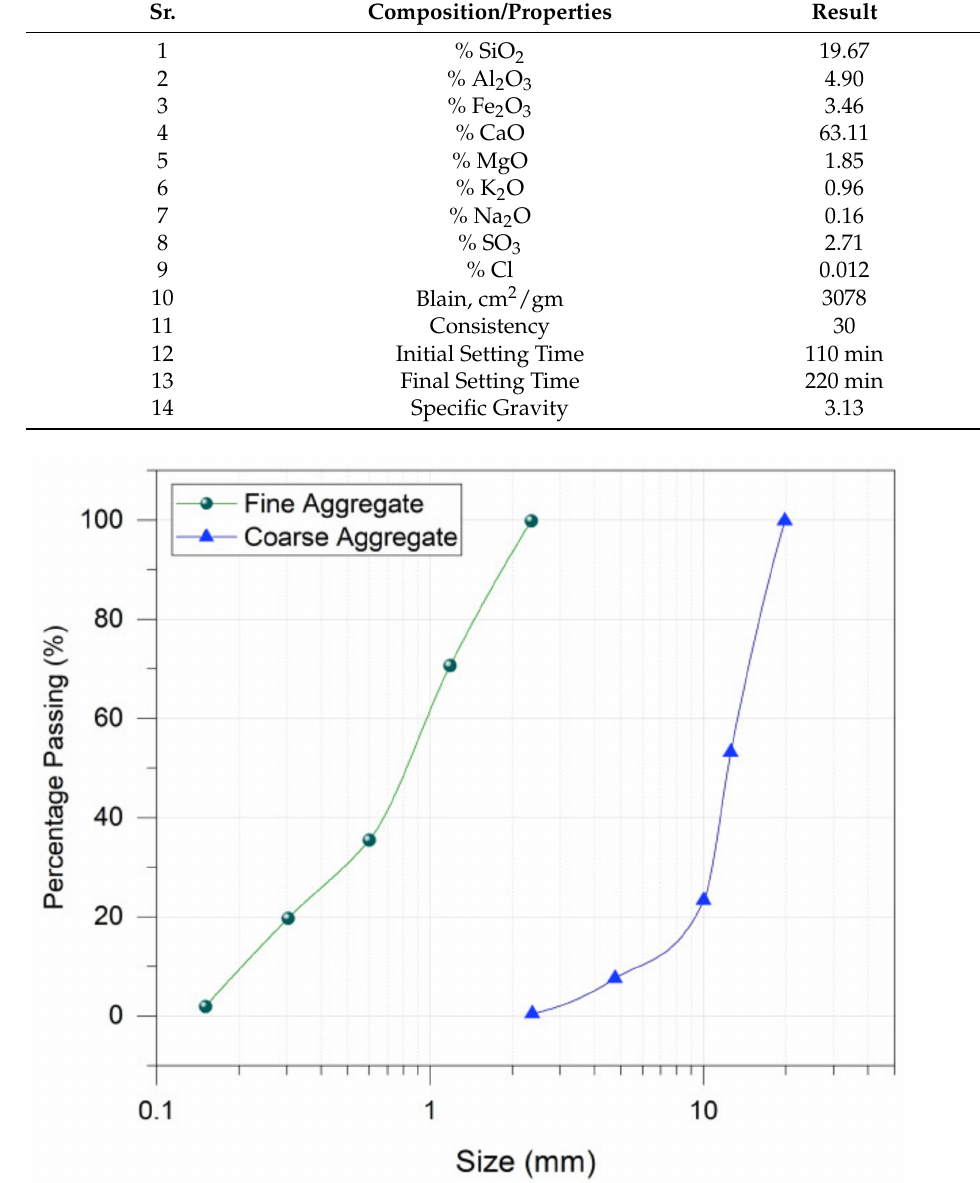
Figure 1. Gradation Curve for Fine aggregate (Sand) and Coarse